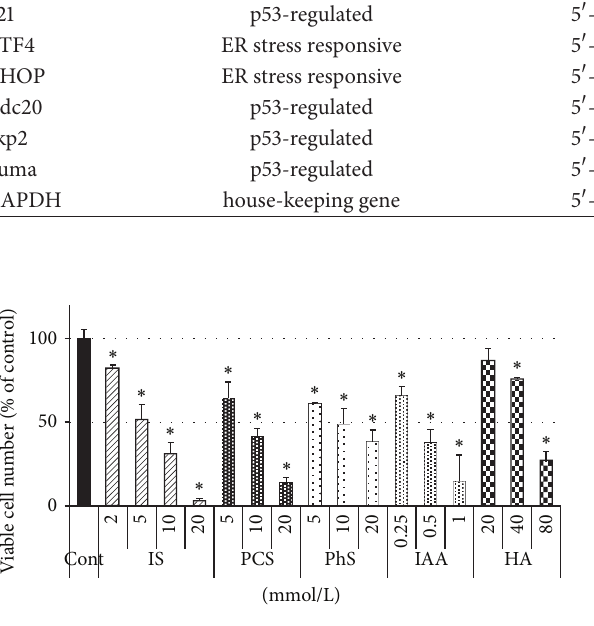
Figure1:Effectsoffiveuremicsolutesonviablecellnumber.Porcine renal tubular cells were treated with each uremic solute for 48 hours. Viable cell number was evaluated using Cell Counting Kit-8. Optical density at 450 nm was measured and the values were calculated as percent of control. Data are shown as mean ± S.D ( 𝑛 = 4 ). Asterisks indicate significant reduction of viable cell population compared to control ( 𝑃 < 0.01 ). Cont, control; IS, indoxyl sulfate; PCS, p -cresyl sulfate; PhS, phenyl sulfate; HA, hippuric